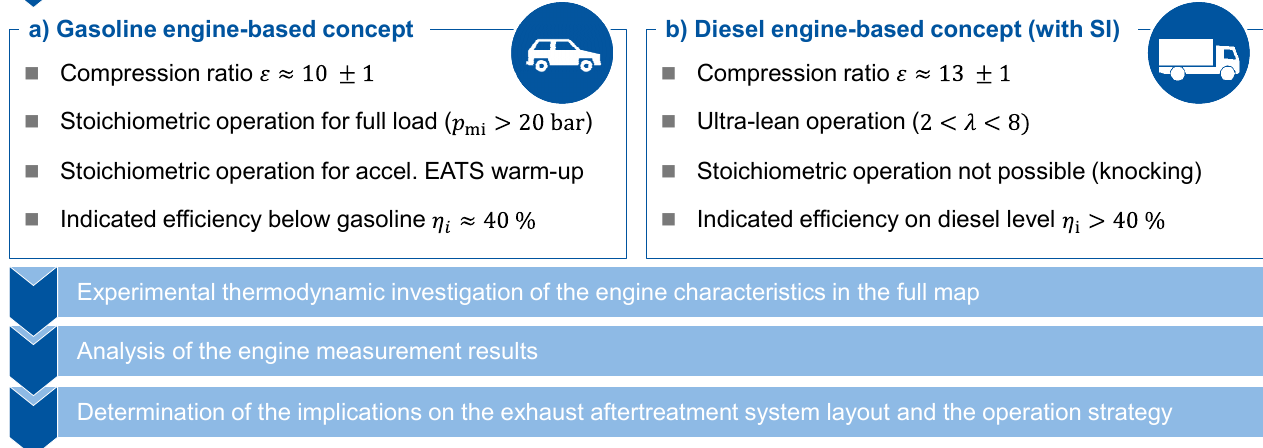
Figure 1. Experimental procedure of this investigation and introduction if the selected H 2 -ICE concepts.